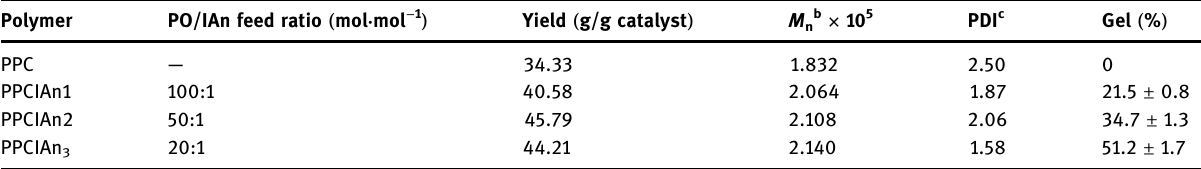
Polymer PO/IAn feed ratio ( mol · mol − 1 )